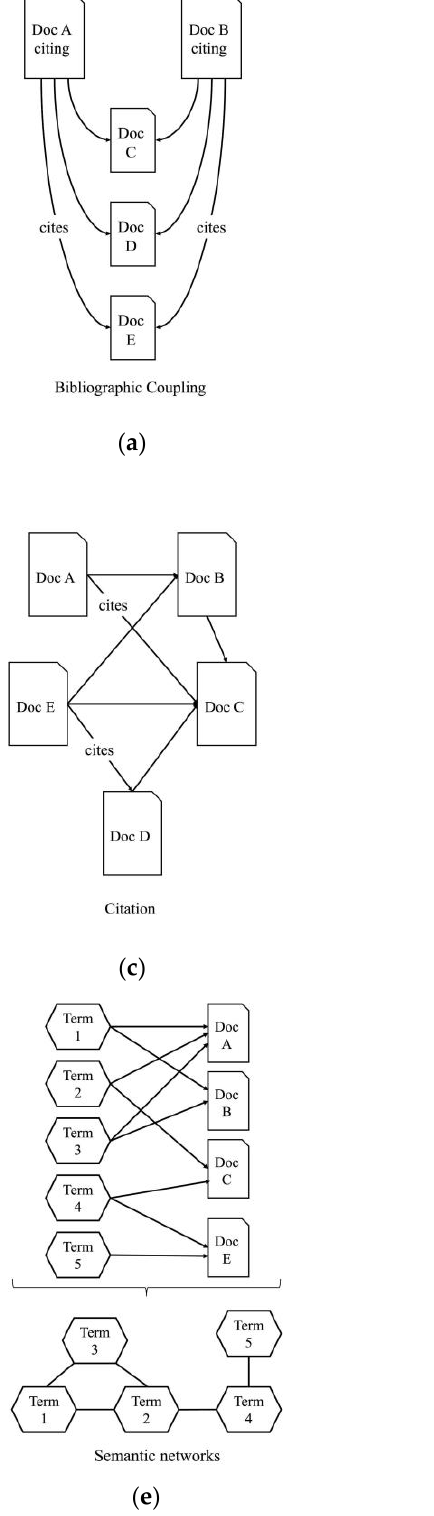
Figure 9. Examples of ( a ) bibliographic coupling, ( b ) co-citation, ( c ) citation, ( d ) co-authorship, and ( e ) semantic networks. Sources: (Phan Tan 2022), VOSviewer Manual , and